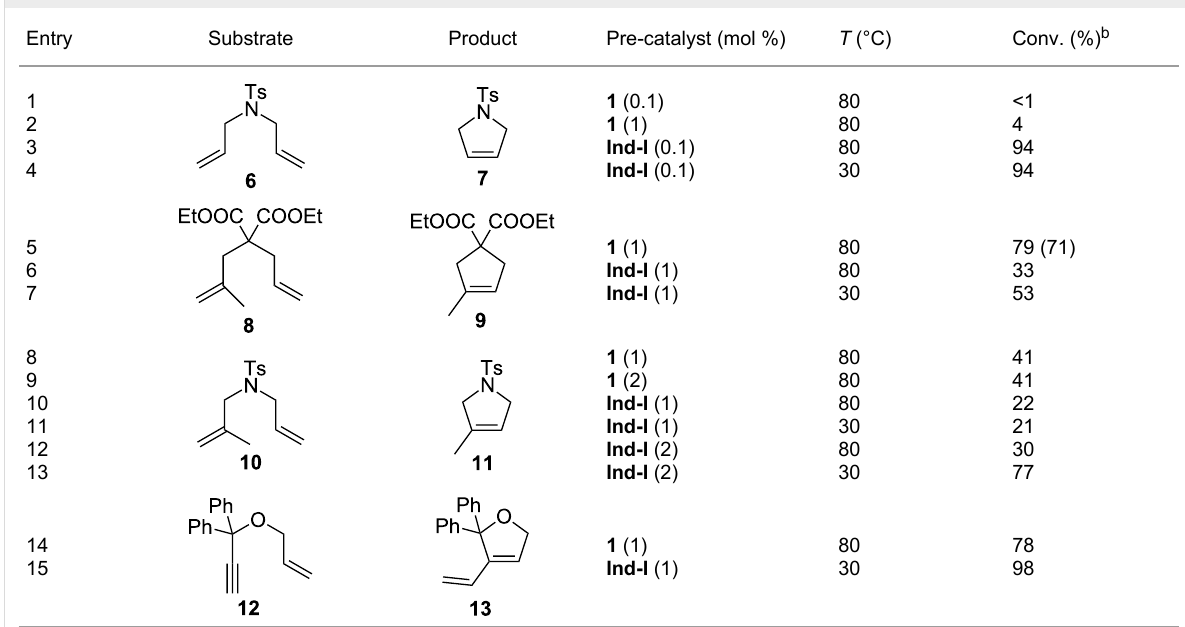
Table 2: Scope of the reaction employing 1 and Ind-I . a Entry